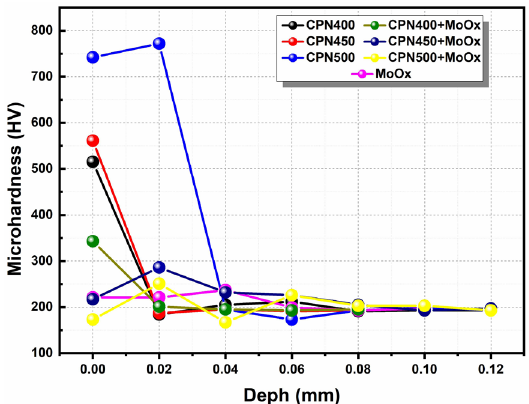
Figure 2. Microhardness values as a function of the layer thickness and the treatment received.